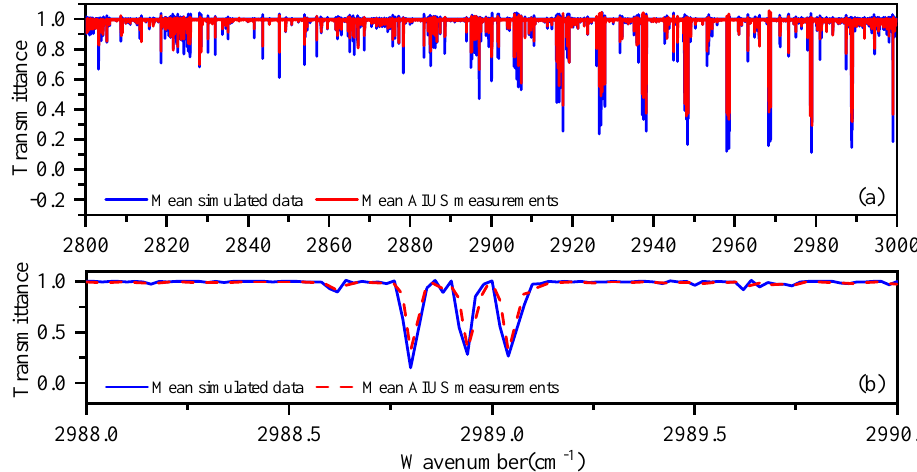
Figure A7. Mean transmittance of AIUS measurements and simulations in 2800–3000 cm − 1 at 40 km. Figure A8 presents the transmittance differences variation with altitudes (15 km, 20 km, 40 km, and 60 km) in 2800–3000 cm − 1 . Figure A8a illustrates that the transmittance differences were in the range of − 0.1 to 0.15 at 60 km. Figure A8b illustrates that